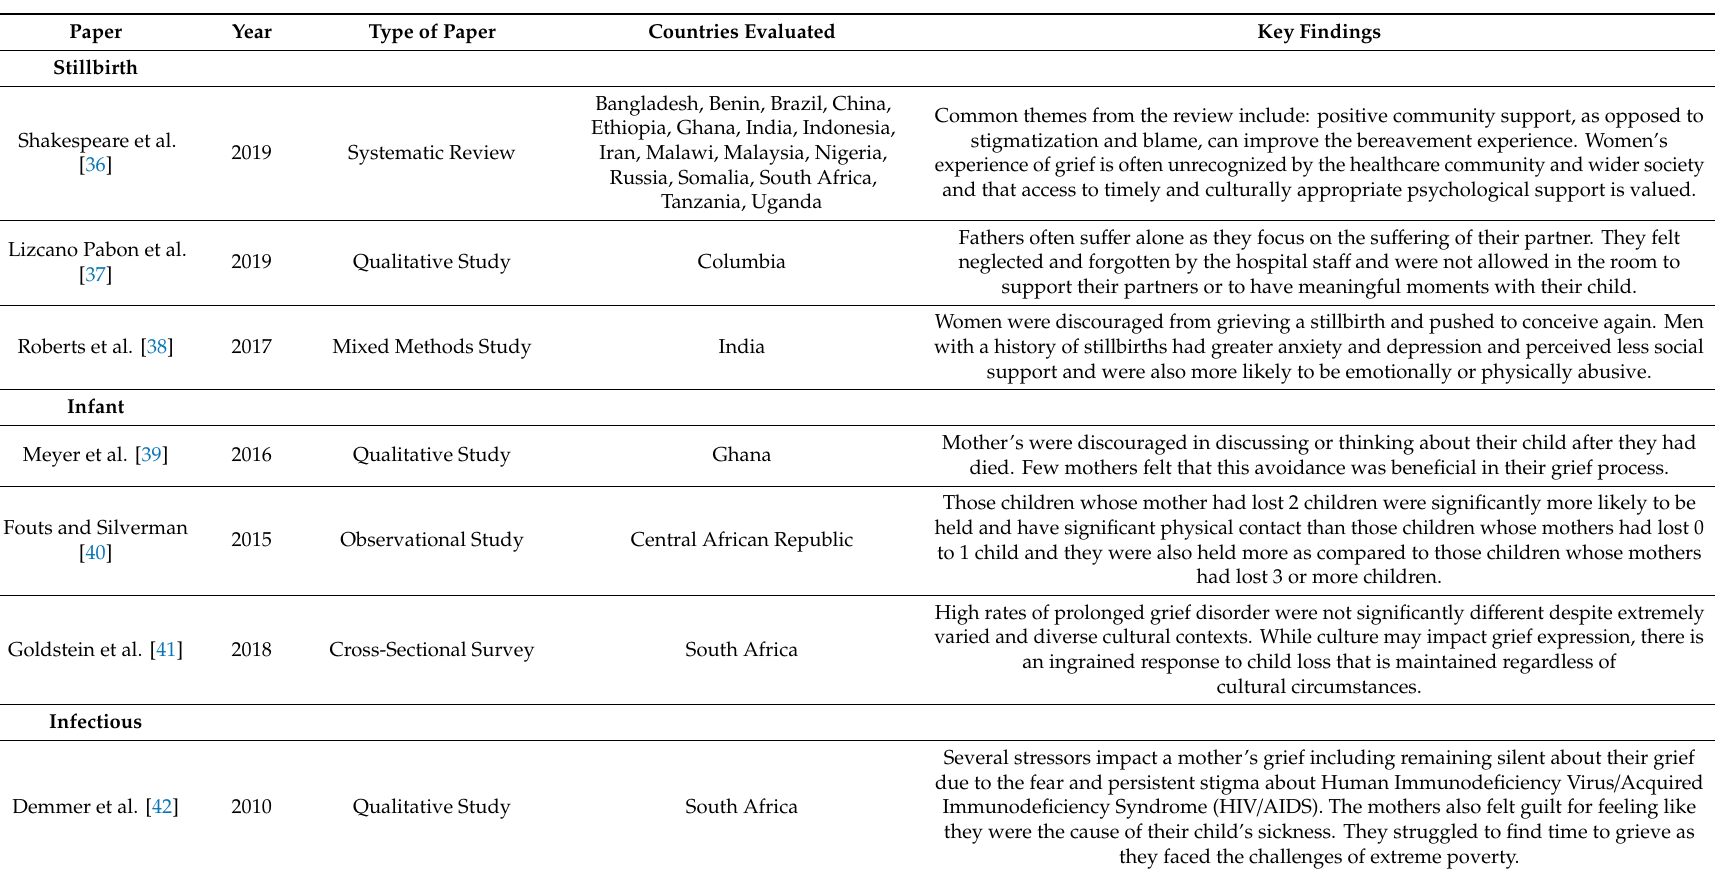
Table 1. Papers evaluating parental grief and bereavement in low- and middle-income